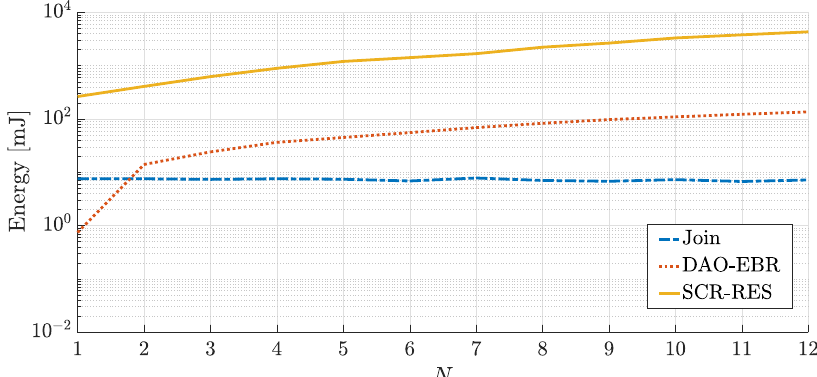
Figure 4. Comparison among energies (log scale) spent by the overall network during different phases of the proposed discovery approach, with CCR set to 8 Hz.